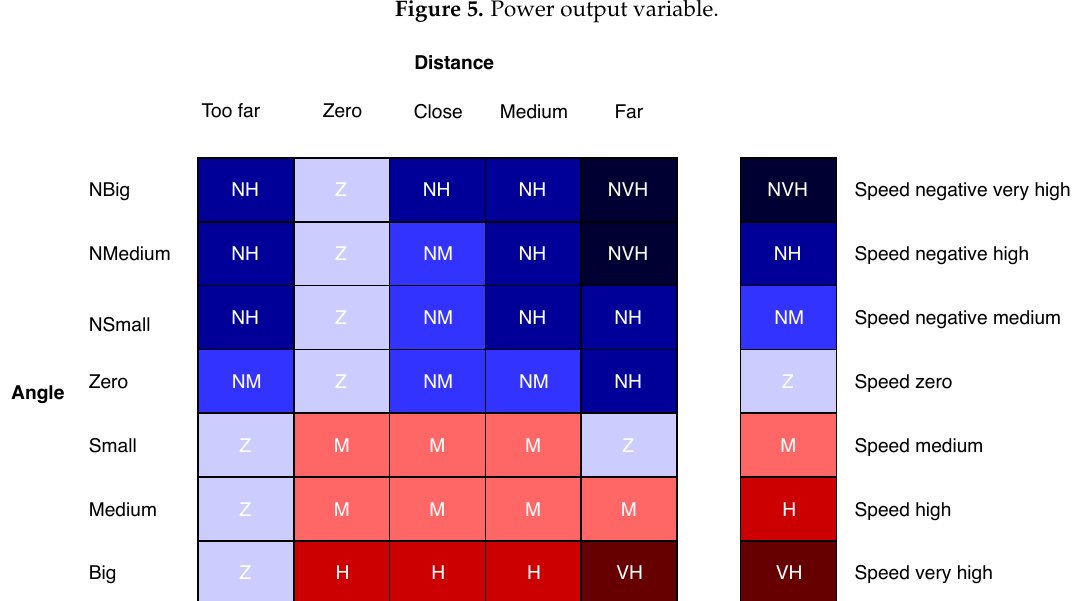
Figure 6. Rule set of the fuzzy control